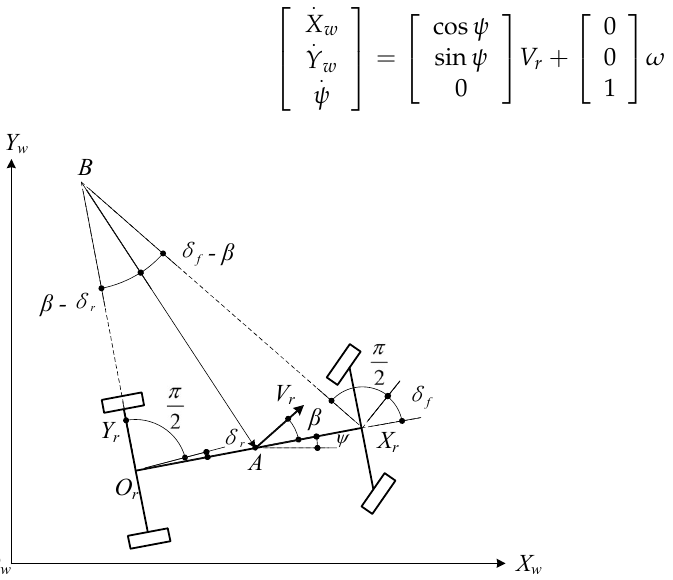
Figure 6. Kinematic model of robot chassis.